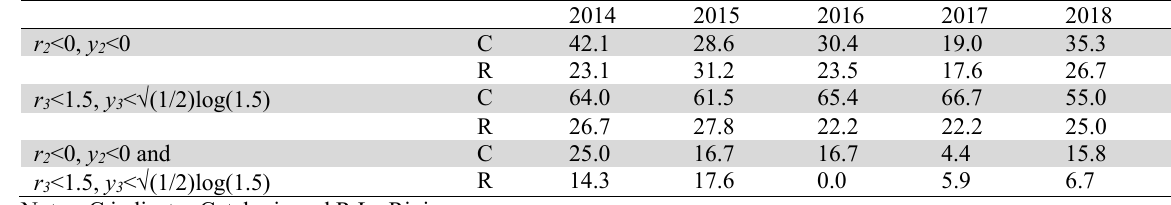
Percentage of firms under liquidity distress according to the cash flow and to the current